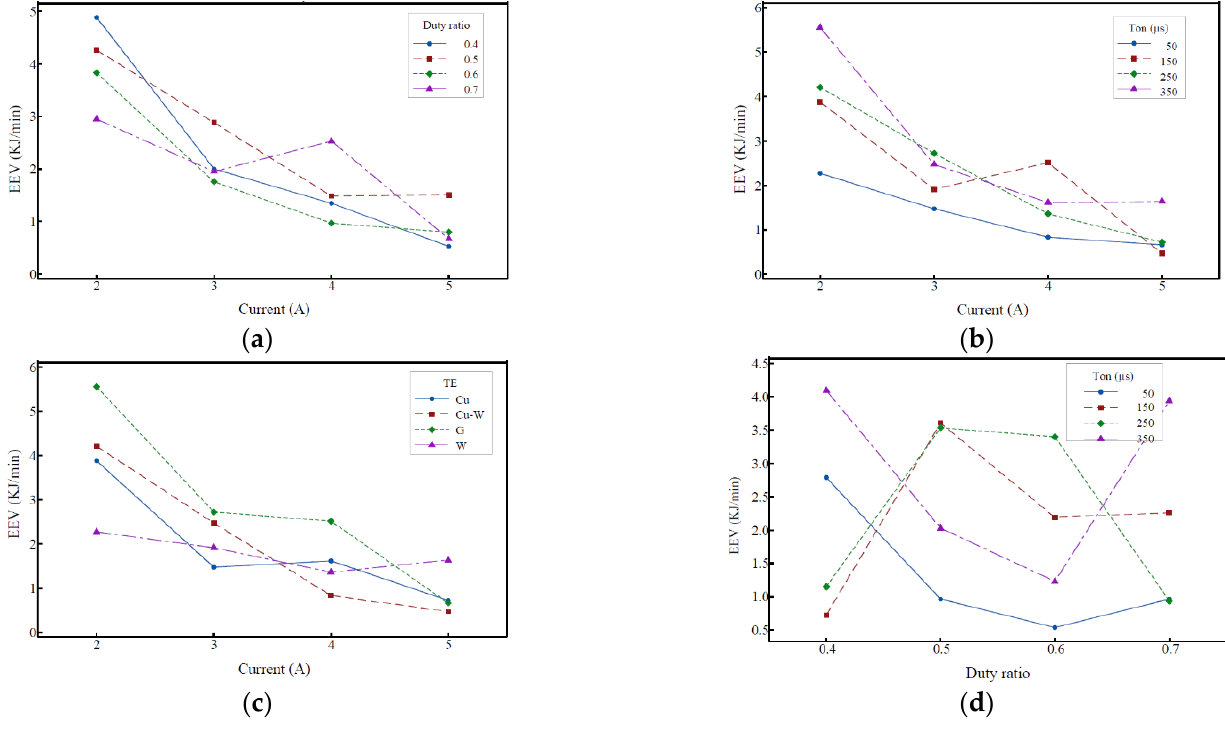
Figure 11. Interaction effect on EEV; ( a ) current and duty ratio on EEV; ( b ) current and pulse duration on EEV; ( c ) current and tool electrode on EEV; ( d ) duty ratio and pulse duration on EEV.